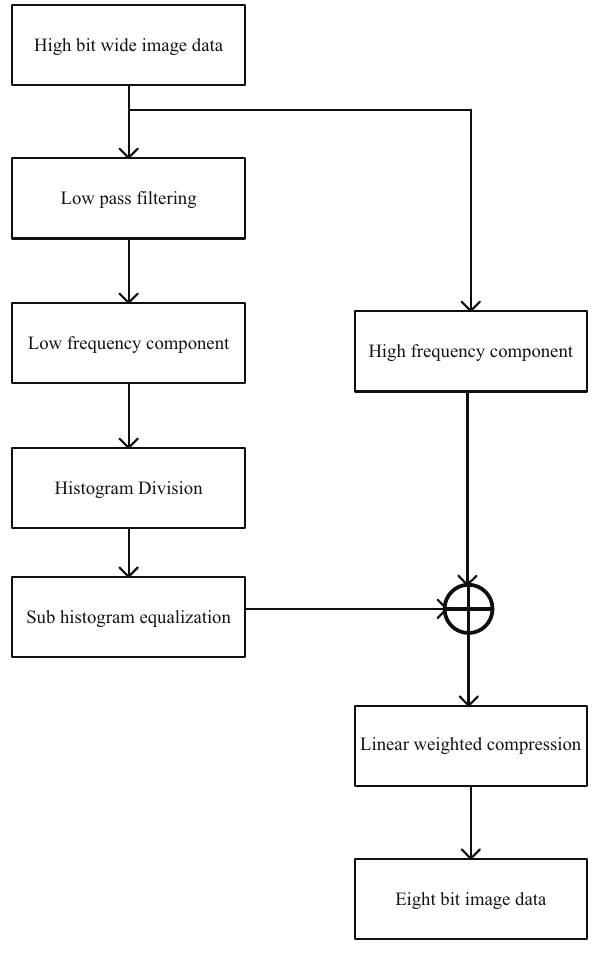
Figure 2: Fine denoising process fl ow of dynamic